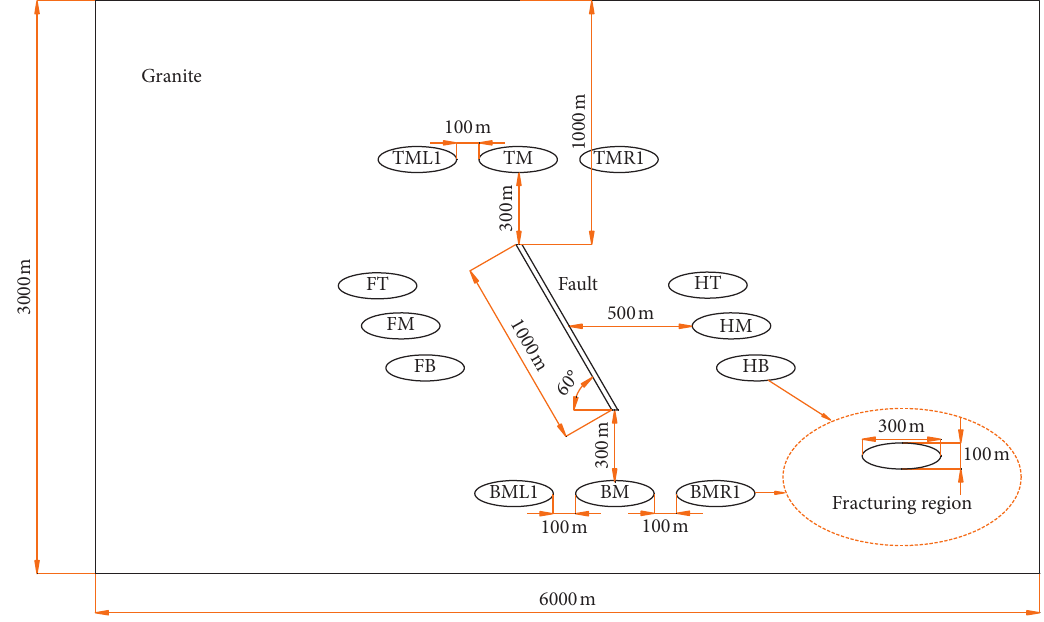
Figure 3: The basic model of hydraulic fracturing in EGS